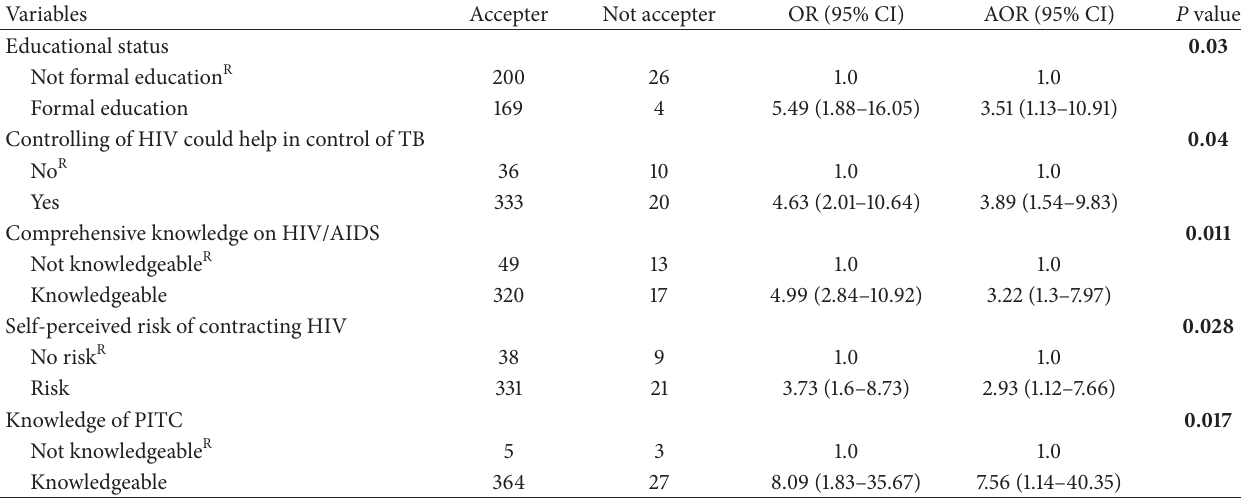
Table 3: Bivariate and multiple logistic regression analysis of factors associated with acceptance of PITC ( 𝑛 = 369 ).